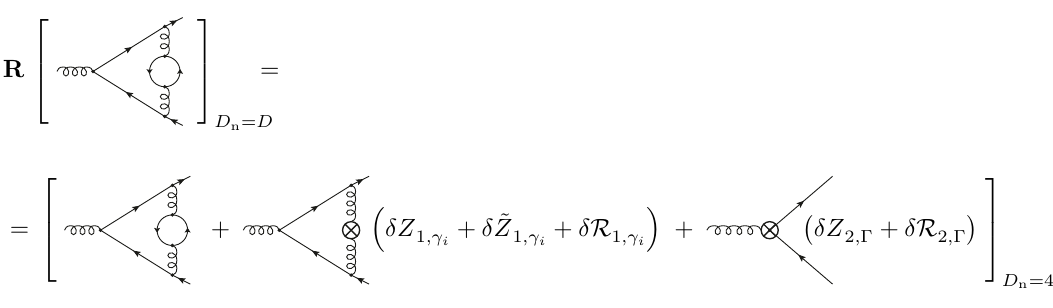
Figure 3 . Graphical representation of the master formula (3.12) for the case of a globally divergent two-loop QCD diagram with a single